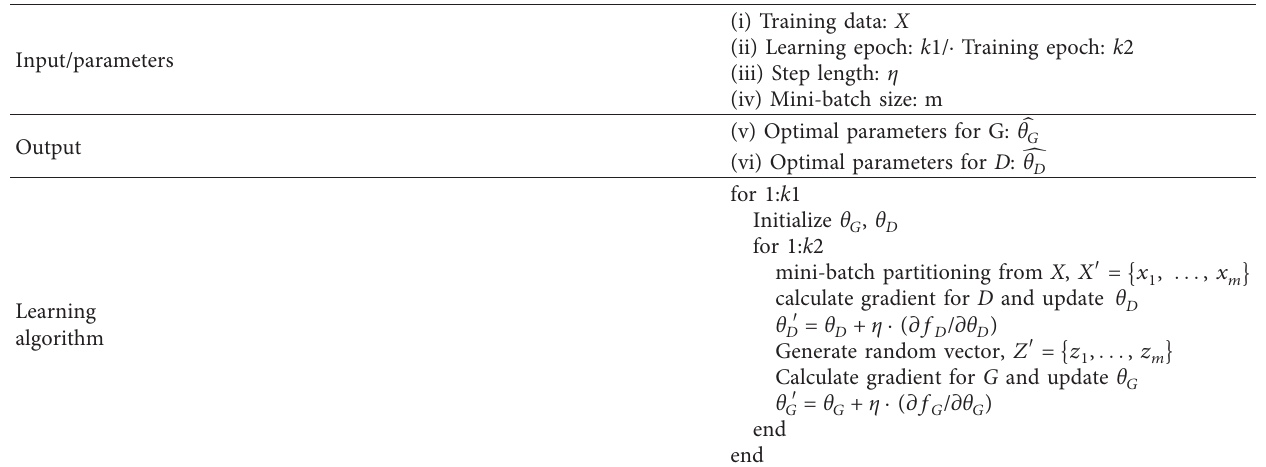
Table 5: General learning algorithm of GAN.